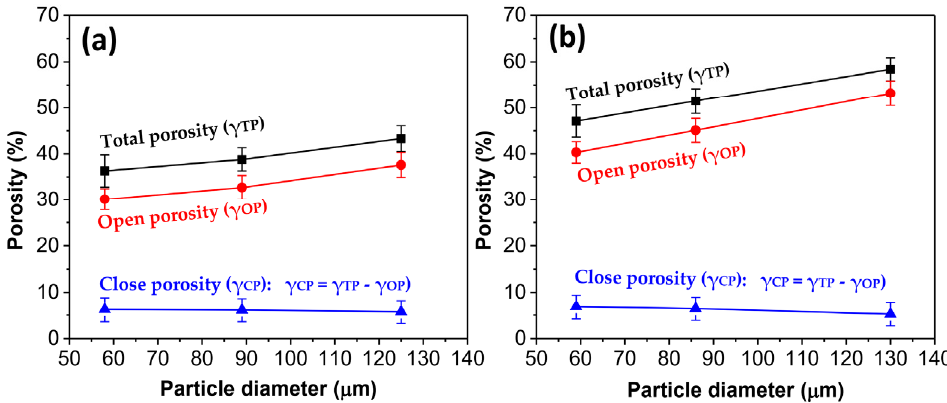
Figure 8. Total porosity, open porosity, and close porosity of porous Cu samples using ( a ) spherical and ( b ) dendritic powders.